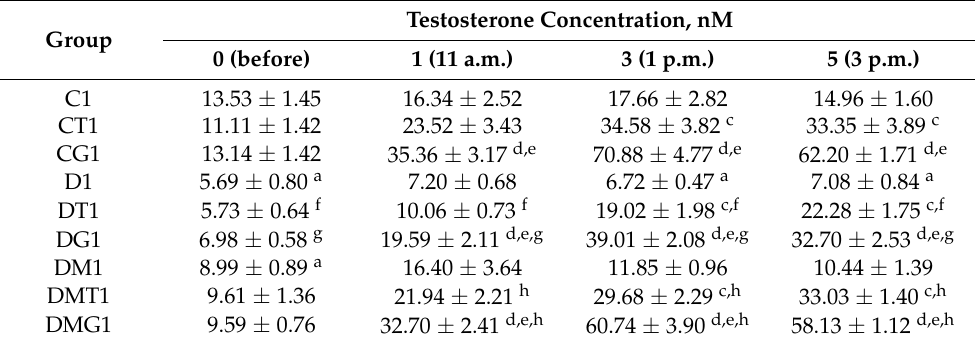
Table 2. The effects of five-week metformin treatment and a single dose of TP3 and hCG on the blood testosterone levels in the control and diabetic animals.